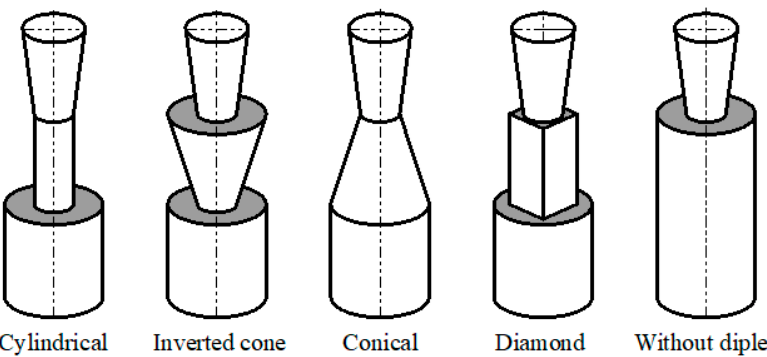
Figure 4. Diplegs and dust settler’s geometry. Drawing made on the base [33].